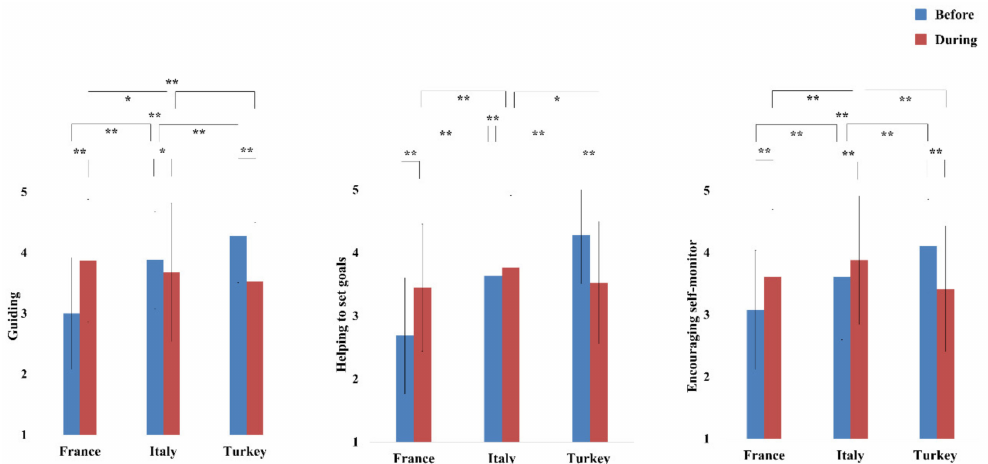
Figure 2. Time × country interactions in the three analyzed teachers’ behaviors. Note. Means and standard deviations are represented. *: p < 0.05; **: p < 0.01.